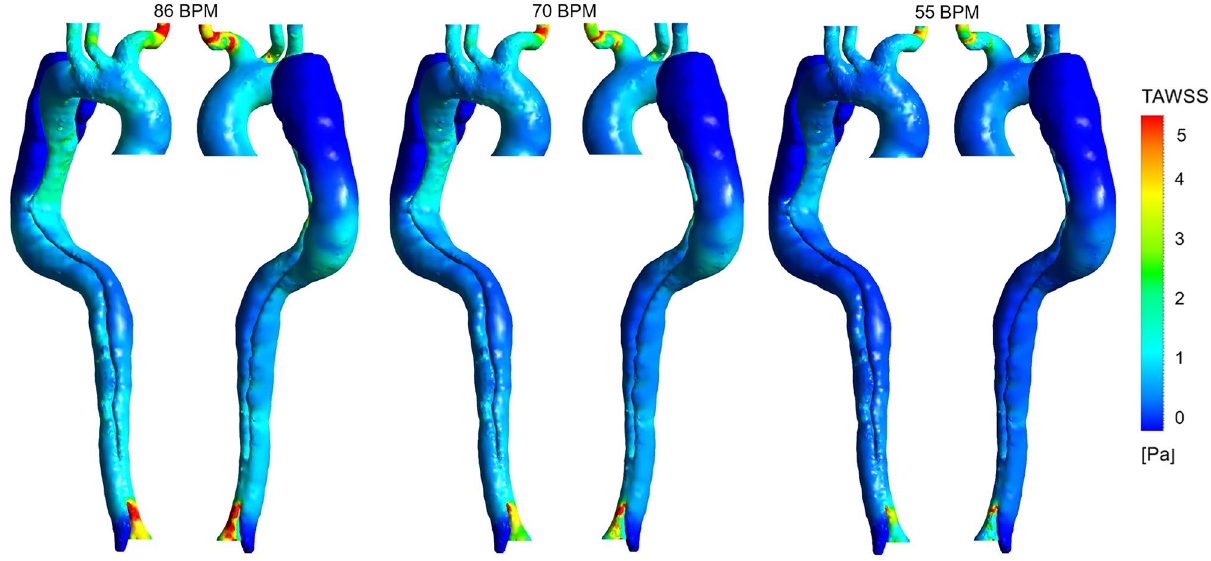
Figure 6. Time-averaged wall shear stress (TAWSS) distribution for three cases (the scale bar shown in the figure indicates all contours).